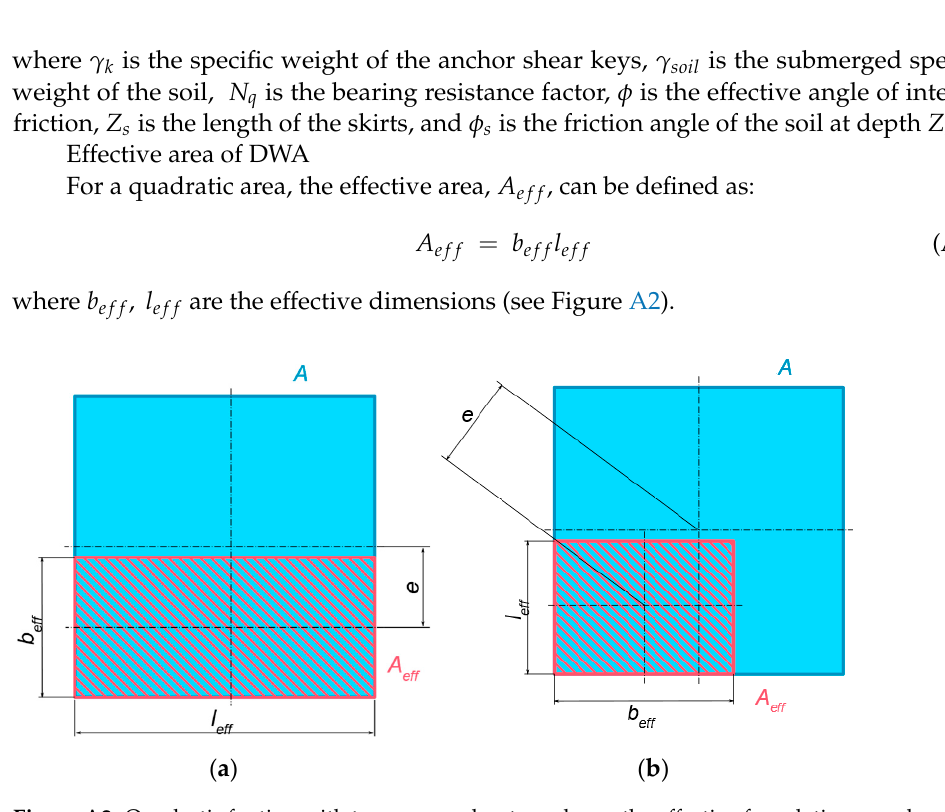
Figure A2. Quadratic footing with two approaches to make up the effective foundation area, based on DNV ‐ OS ‐ J101 [15]. ( a ) Load eccentricity with respect to only one symmetry axis; ( b ) Load eccentricity with respect to both symmetry axes.